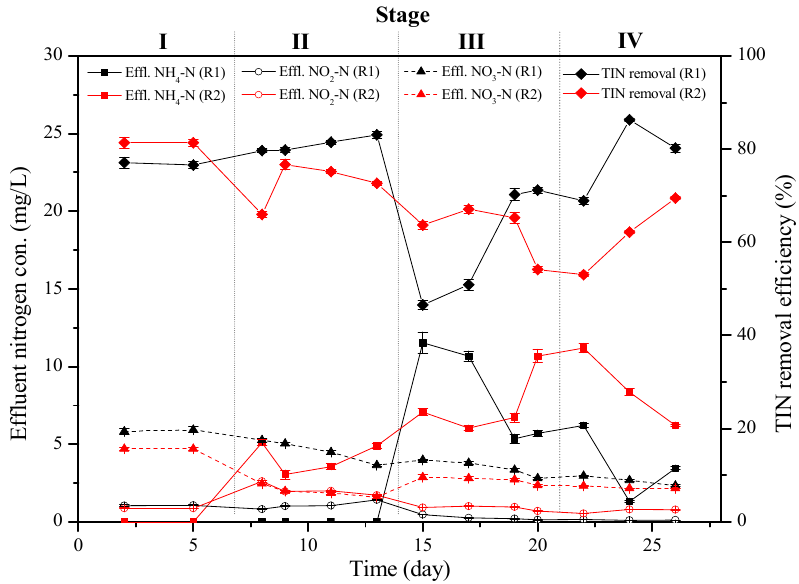
Figure 5. Profiles of the effluent nitrogen species from R1 and R2, and their TIN removals during the 28 days of operation.